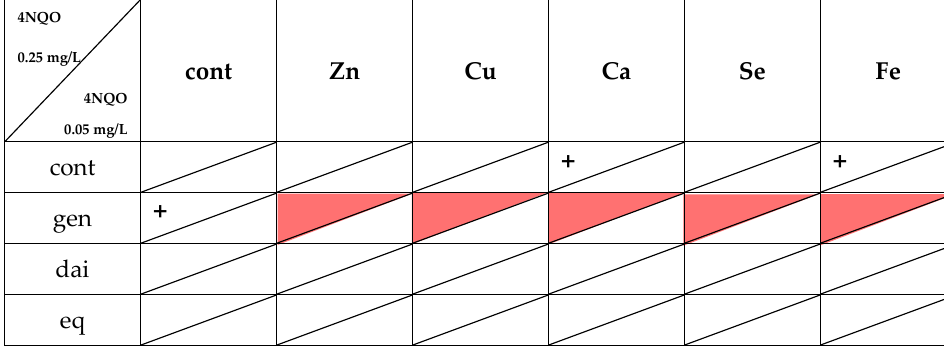
Table 4. Summary of anti-genotoxic activity of isoflavonoids, minerals and their combinations against direct mutagen 4NQO (0.25 mg/L; 0.05 mg/L). 4NQO